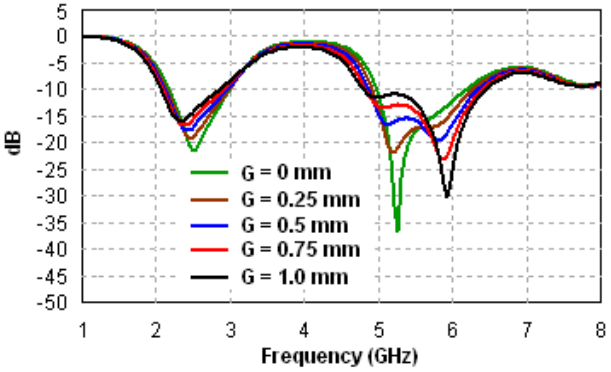
Figure 9: The S 11 responses of the 3rd iteration Koch fractal monopole antenna of Figure 6(b) with G as the parameter The effect of the variation of GRD on the antenna performance has been shown in Figure 10. The antenna ground plane extension U and the spacing G are maintained constant at 10 mm and 1.0 mm respectively while the ground plane width has been varied from 30 mm to 40 mm in steps of 2 mm. As the GRD increases, the lower resonant band is slightly affected; its position is shifted down while the corresponding bandwidth is broadened. On the other hand, the upper resonant band is shifted down in with narrowing bandwidth. However, the variation of the upper resonant band covers a broad frequency range starting from about 5.0 to 6.35 GHz.